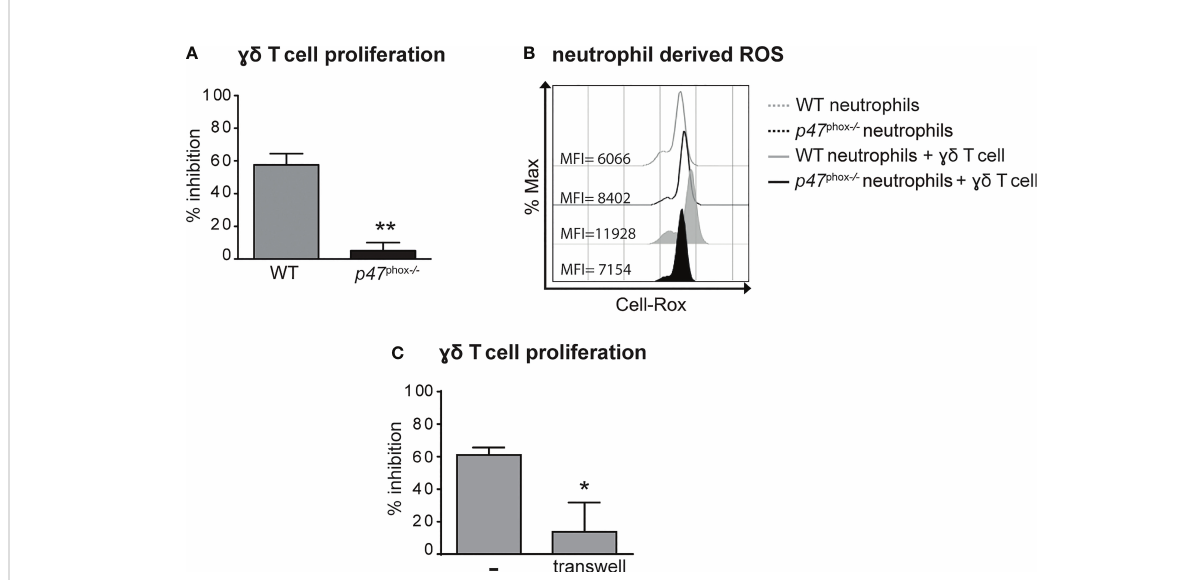
FIGURE 6 Neutrophil-mediated inhibition of gd T cell proliferation requires (NADPH) oxidase-dependent ROS production and direct cell-to-cell contacts. gd T cells were stimulated with CD3/CD28, 100 ng/ml IL-23 plus 10 ng/ml IL-1 b and cultured with neutrophils from either wild-type (WT) or p47 phox-/- mice for 72 (A, C) or 3 (B) hours. (A) Percentages of inhibition of gd T cell proliferation by neutrophils from WT or p47 phox-/- mice as measured by BrdU incorporation. (B) Representative FACS histogram plots depicting the Cell-RoX MFI of CD11b + Ly6G + neutrophils from WT or p47 phox-/- mice in the presence or absence of gd T cells, as evaluated by FACS analysis. (C) Stimulated gd T cells were cultured with neutrophils under direct contact or transwell conditions. The graph shows the percentages of inhibition of gd T cell proliferation, as measured by BrdU incorporation. Graph values indicate means ± SD from 2 independent experiments. * P ≤ 0.05; ** P ≤ 0.01, by t- test.